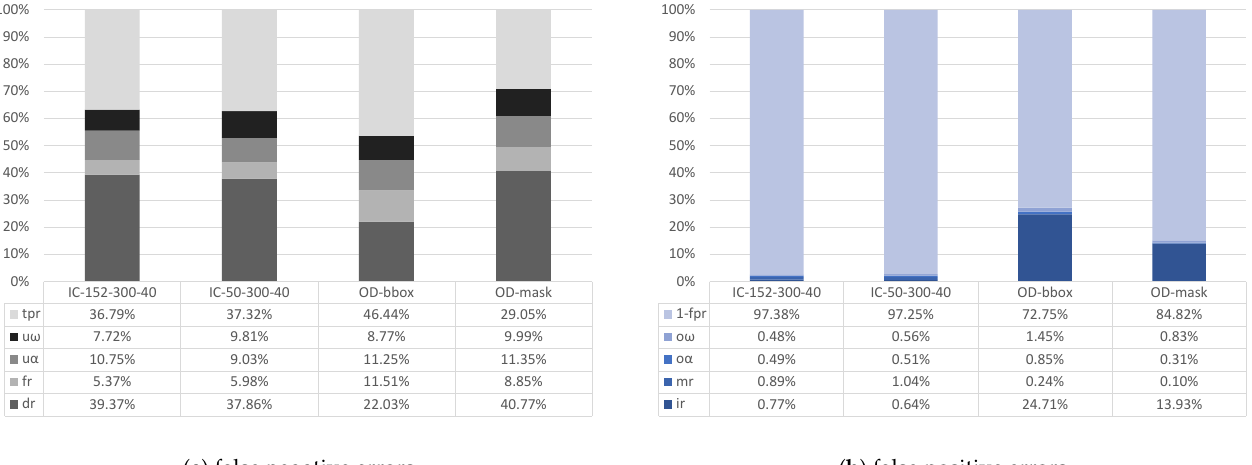
Figure 3. Frame metrics with respect to positive ( a ) and negative ( b ) ground truth frames across all